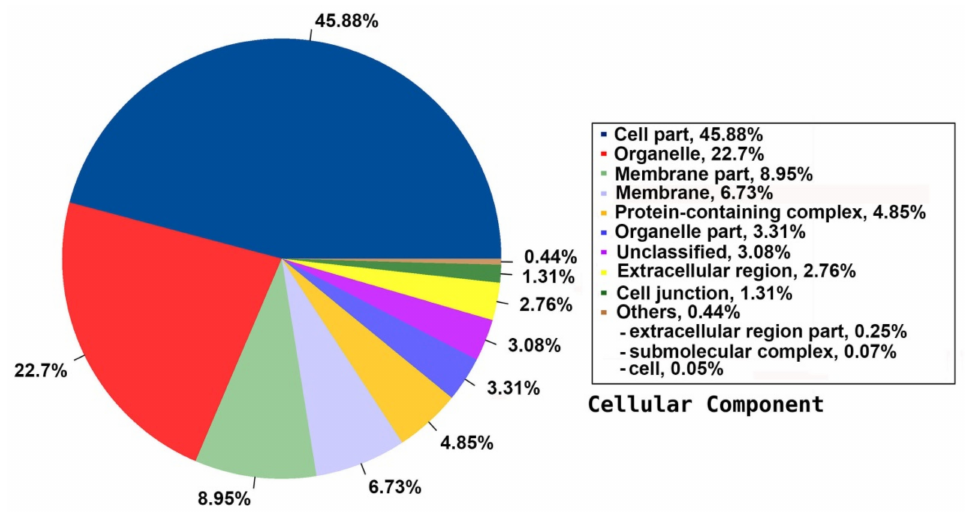
Figure 4. Distribution of the annotated CC to the GO database using the detected unigenes of the jojoba transcriptome of developing seeds.